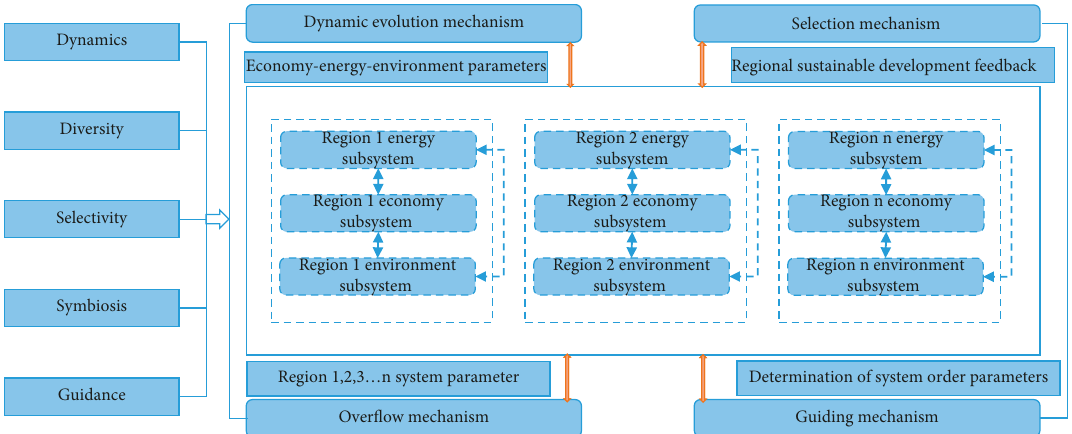
Figure 2: The evolution mechanism of the EEE complex system.